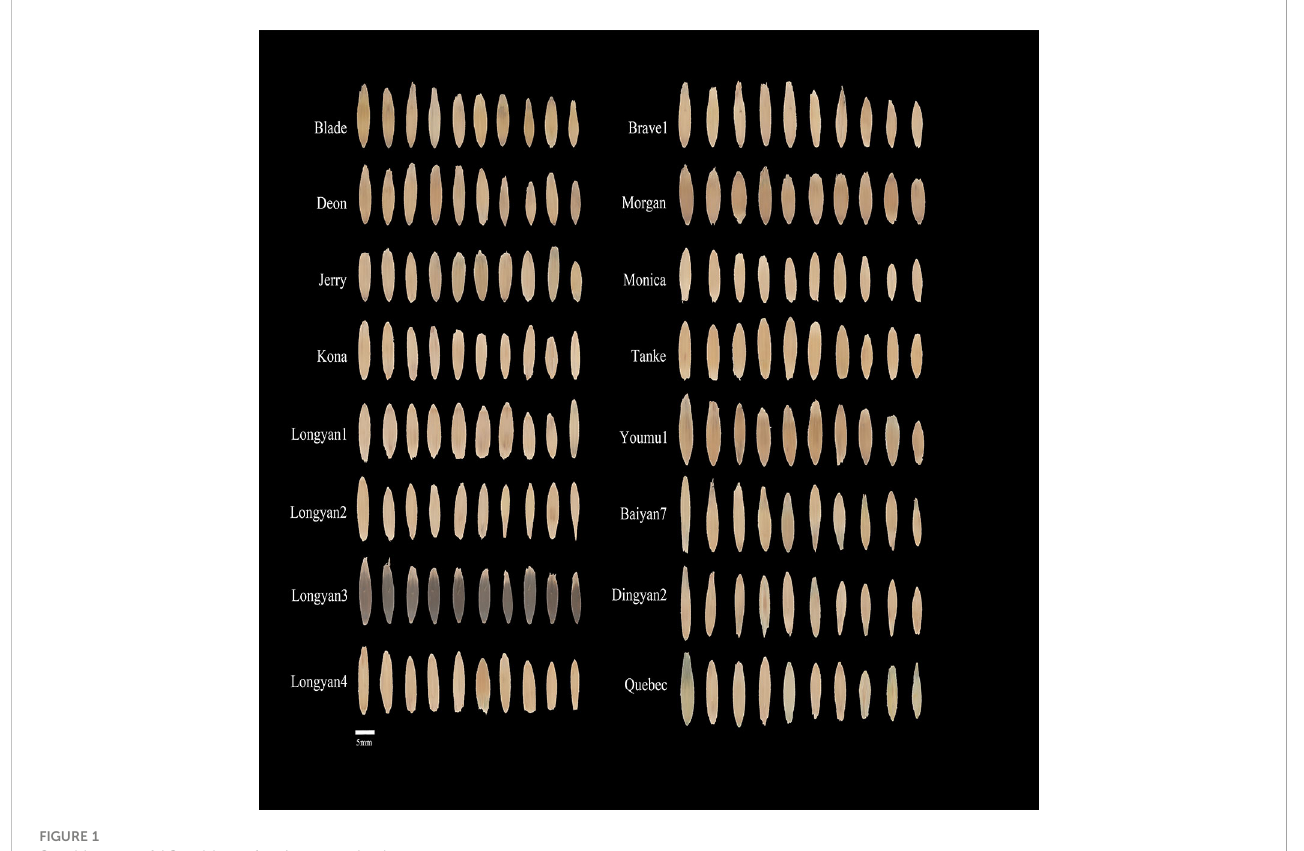
FIGURE 1 Seed image of 16 cultivars for Avena sativa